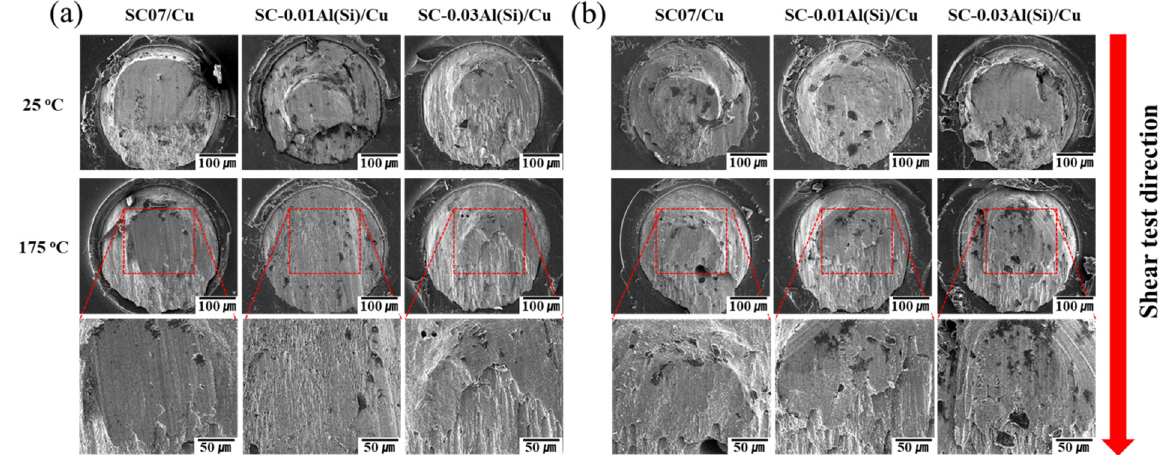
Figure 13. Fracture surfaces of the solder joints under various shear speeds: ( a ) as-reflow and ( b ) 10 reflows.